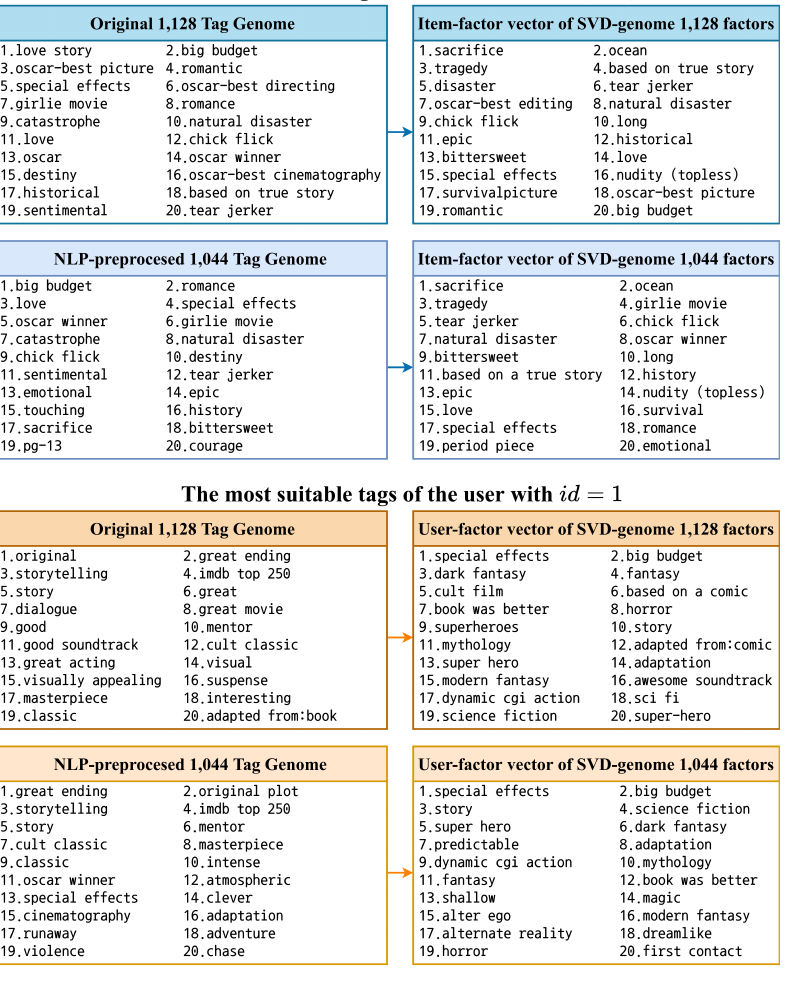
Figure 5. The 20 most relevant tags of the movie Titanic (1997) and the user with id = 1 based on the original Tag Genome and the feature vectors after training SVD-genome